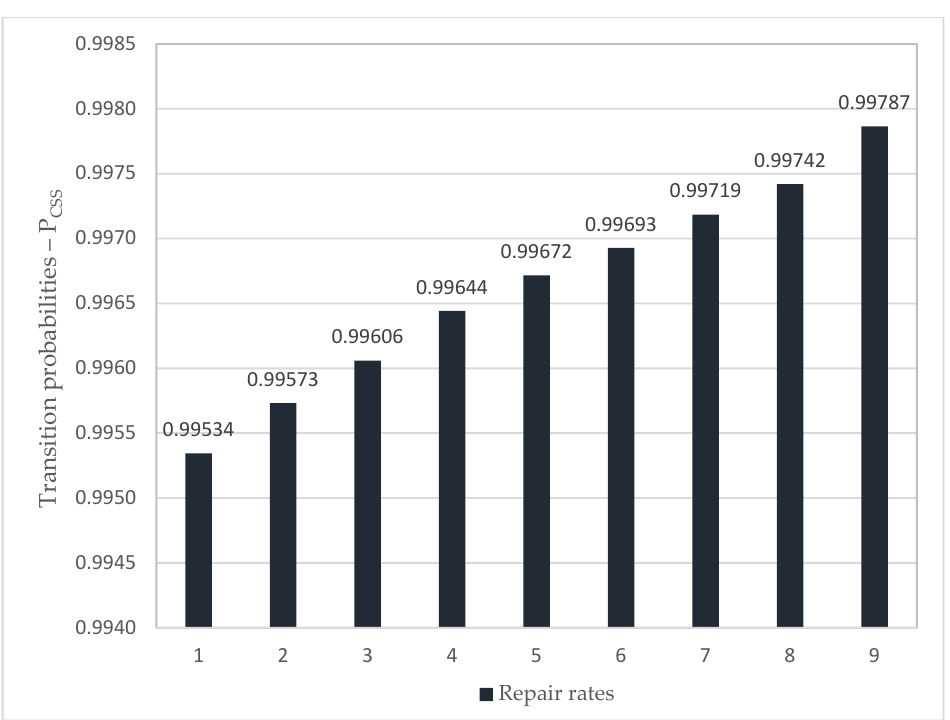
Figure 6. Repair rates for µ TSS and µ LSS .